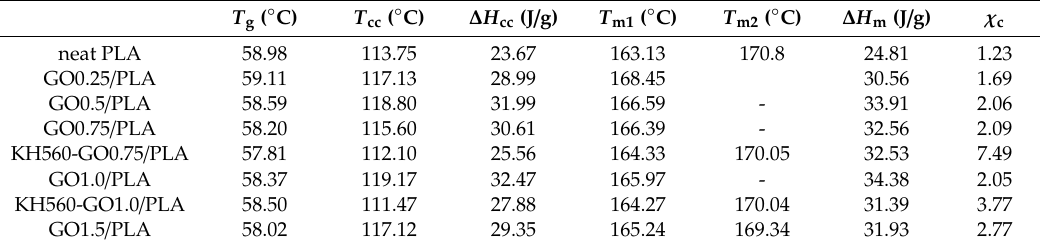
Table 1. The list of thermal properties of GO / PLA and KH560-GO / PLA nanocomposites obtained from DSC